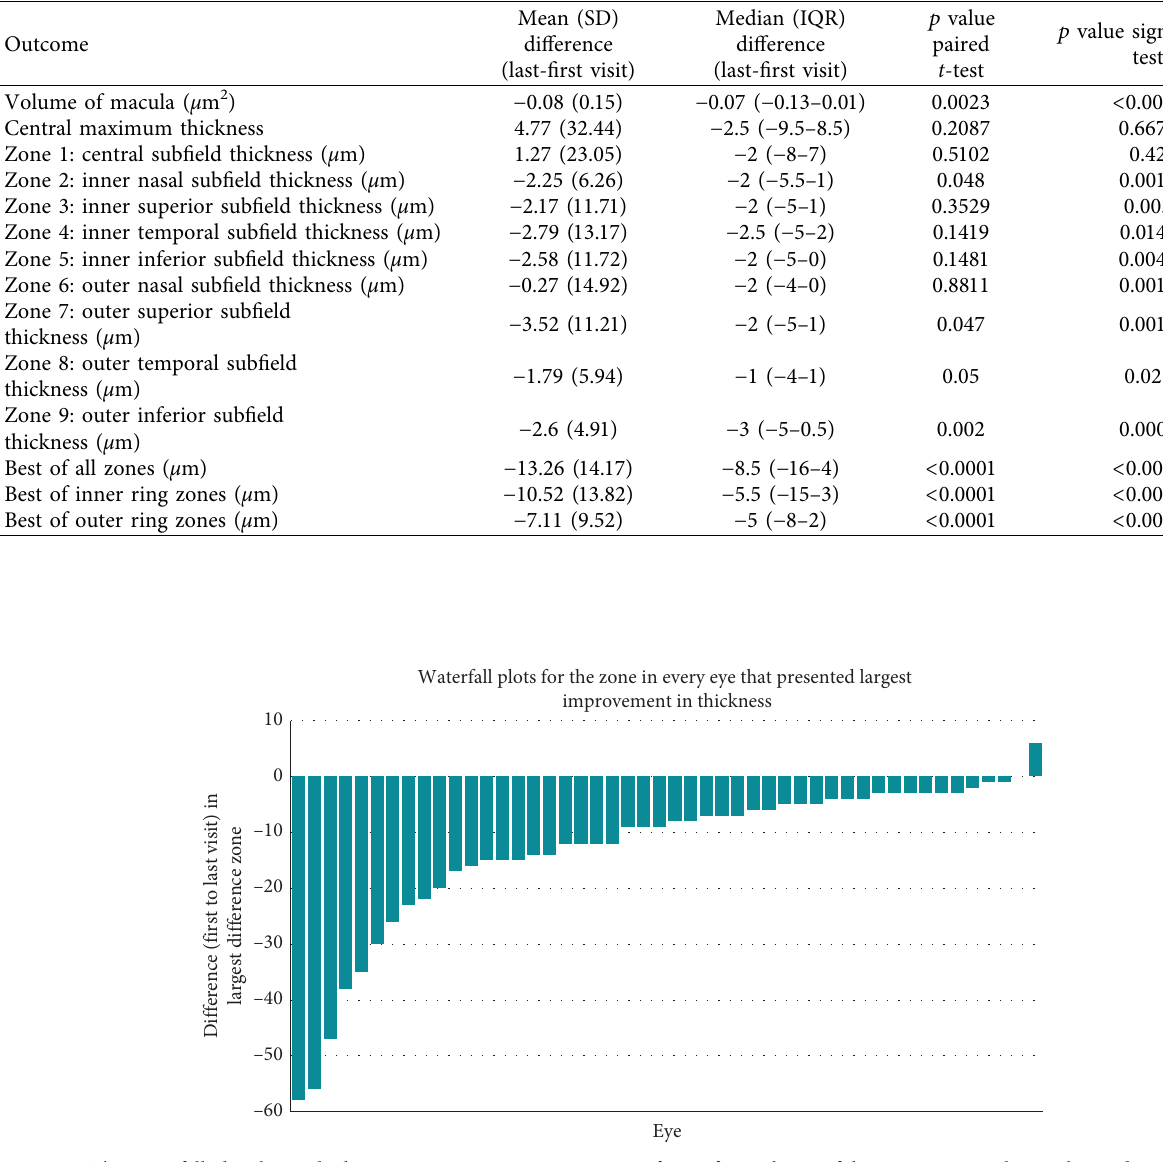
Figure 5: The waterfall plot shows the largest improvement irrespective of zone for each eye of the patients completing the study. Only 1 eye deteriorates in every zone. The vast majority showed some level of thinning (46/48). Some eyes that show marked improvement in their best zone (10/48) show 20 μ m thinning or